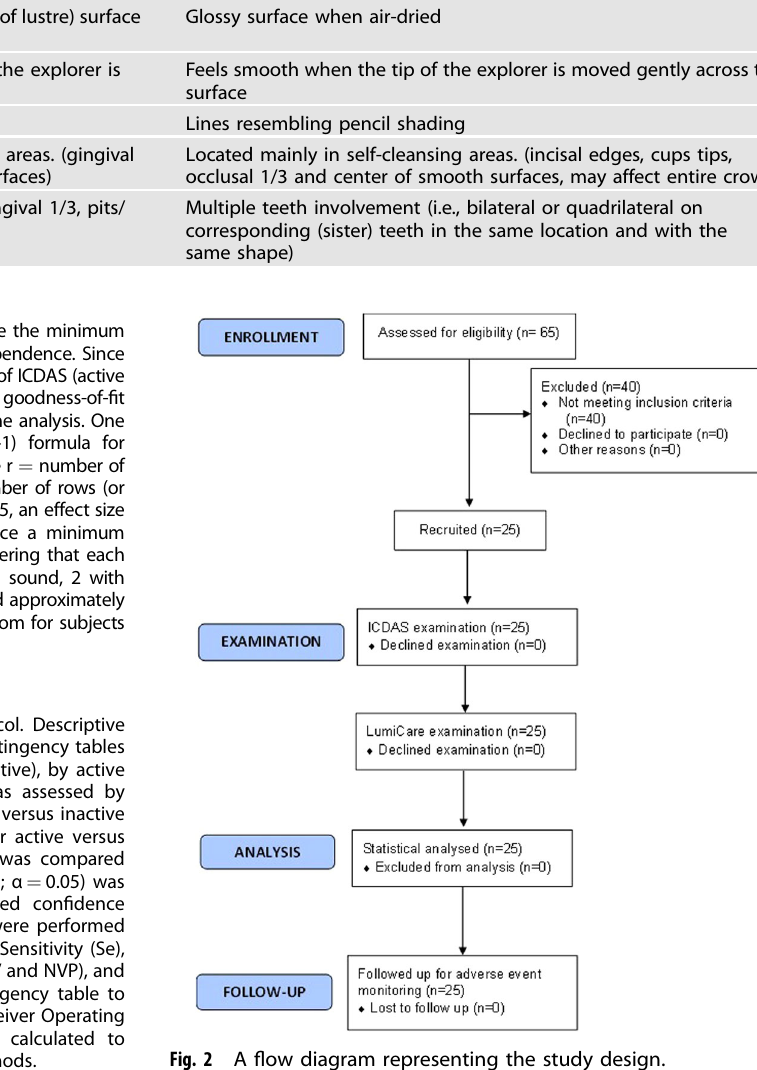
Table 2. Differentiating the causes of white spot lesions as caries versus developmental hypomineralization [26, 27]. Criteria for Distinction